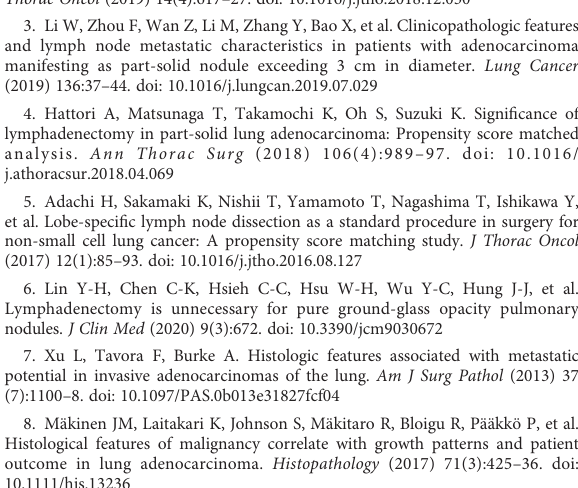
SUPPLEMENTARY FIGURE 1 Comparison of tumor size, solid part size, and CTR to predict lymph node metastasis in PSILA. The area under the ROC curve (AUC) was used to assess the predictive performance of different